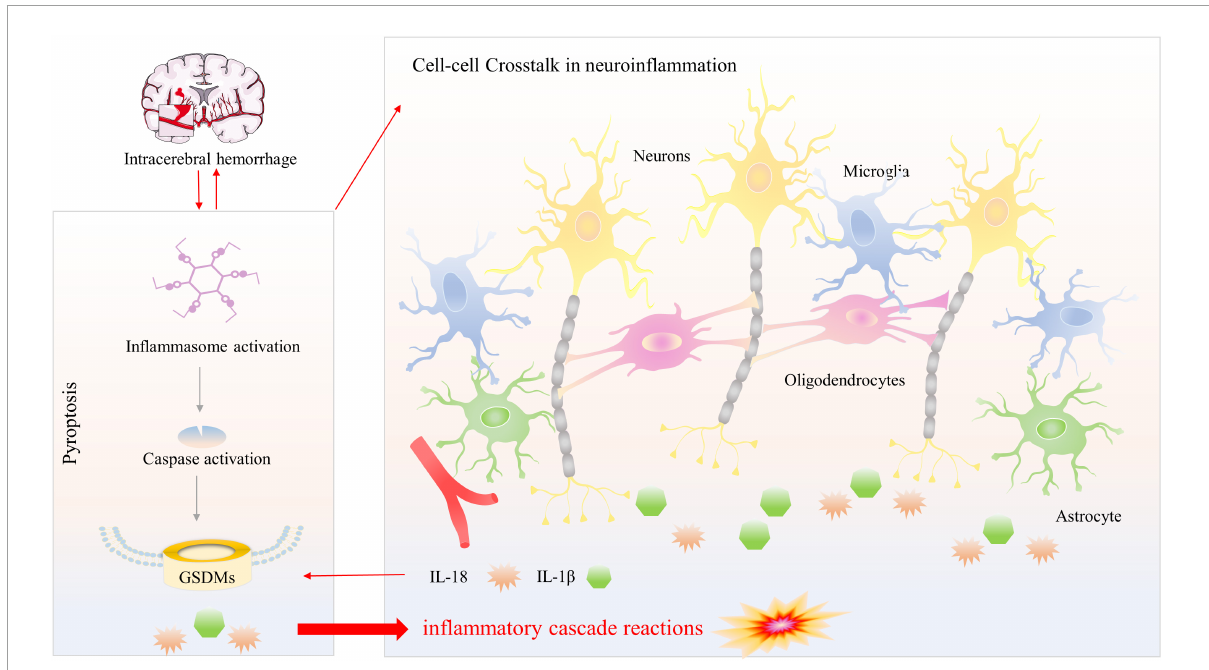
FIGURE4 Pyroptosis versus neuroinflammation among multiple CNS cells. Activation of inflammasome following ICH promotes communication between CNS cells, that different signals crosstalk affect neuroinflammation and produce inflammatory cytokines (IL-1 β and IL-18). Meanwhile, inflammasome activation results in caspase-1-mediated cleavage of GSDMD. N-GSDMD transformed into the cellular membrane to form non-selective pores, leading to the subsequent release of the mature inflammatory cytokines, causing magnify neuroinflammation and generating inflammatory cascade